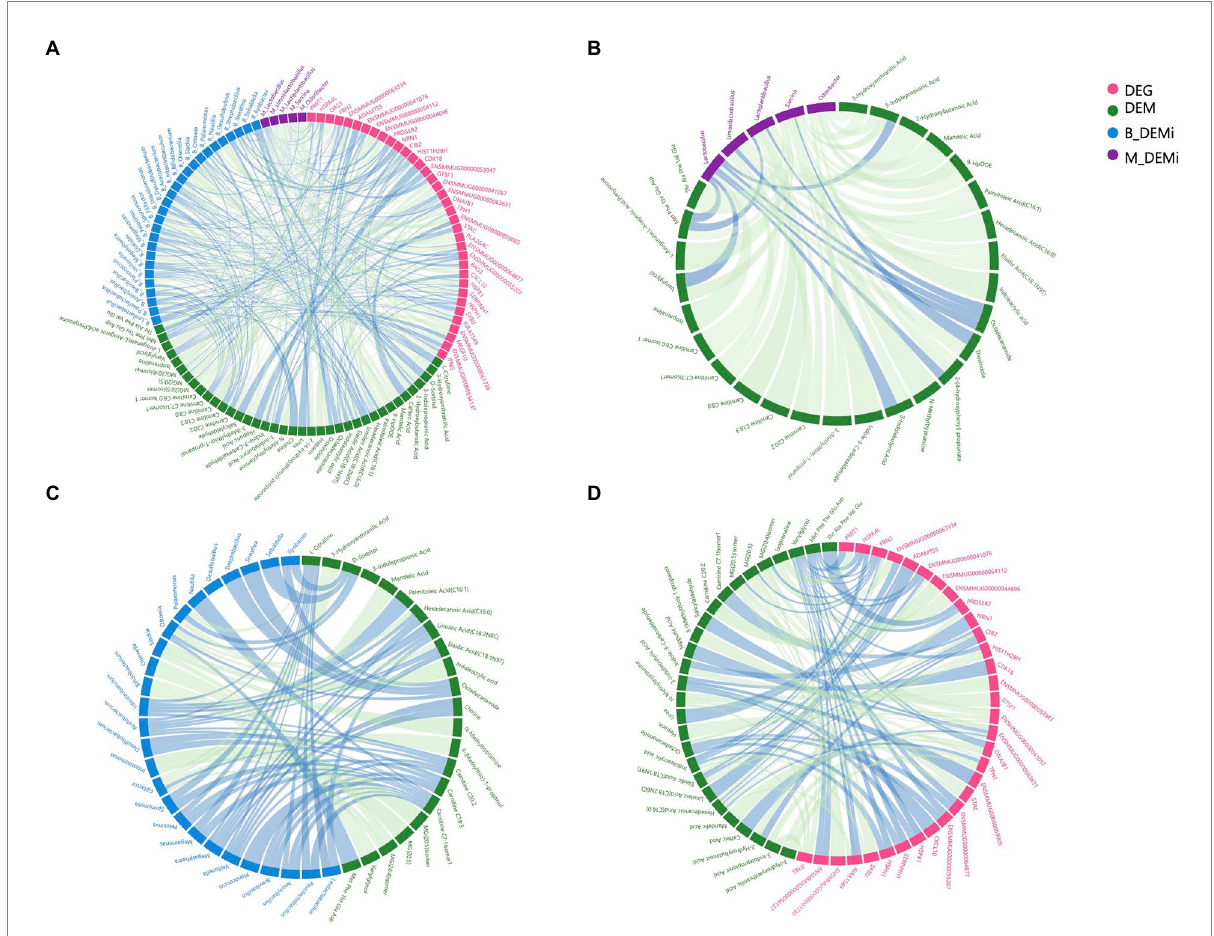
FIGURE 4 Association analysis among multi-omics. (A) Correlation network of variables that differed significantly between young and old groups of each omics. (B) Correlation network of differential gut microbial genera and DEMs. (C) Correlation network of differential oral microbial genera and DEMs. (D) Correlation network of DEGs and DEMs. DEGs: differentially expressed genes; DEMs: differentially expressed metabolites; B_DEMi: differentially expressed oral microbiota; M_DEMi: differentially expressed gut microbiota. All nodes and edges of correlation networks, with lines indicating significant correlations ( p < 0.05). Blue lines indicate positive correlation and green lines indicate negative correlation.